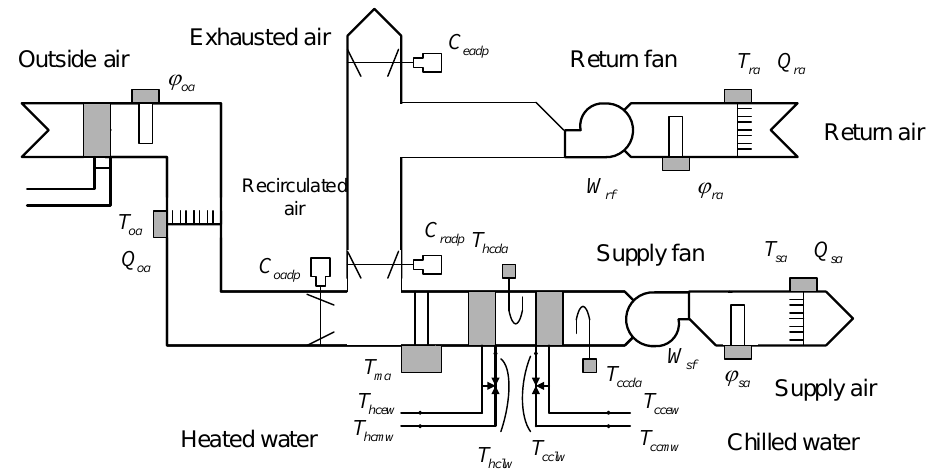
Figure 3. A typical single-duct AHU system with deployed sensors. Instrumentation consisting of humidity, pressure, and temperature sensors, air flow stations, and electric power meters are available to monitor the operational characteristics of the AHU